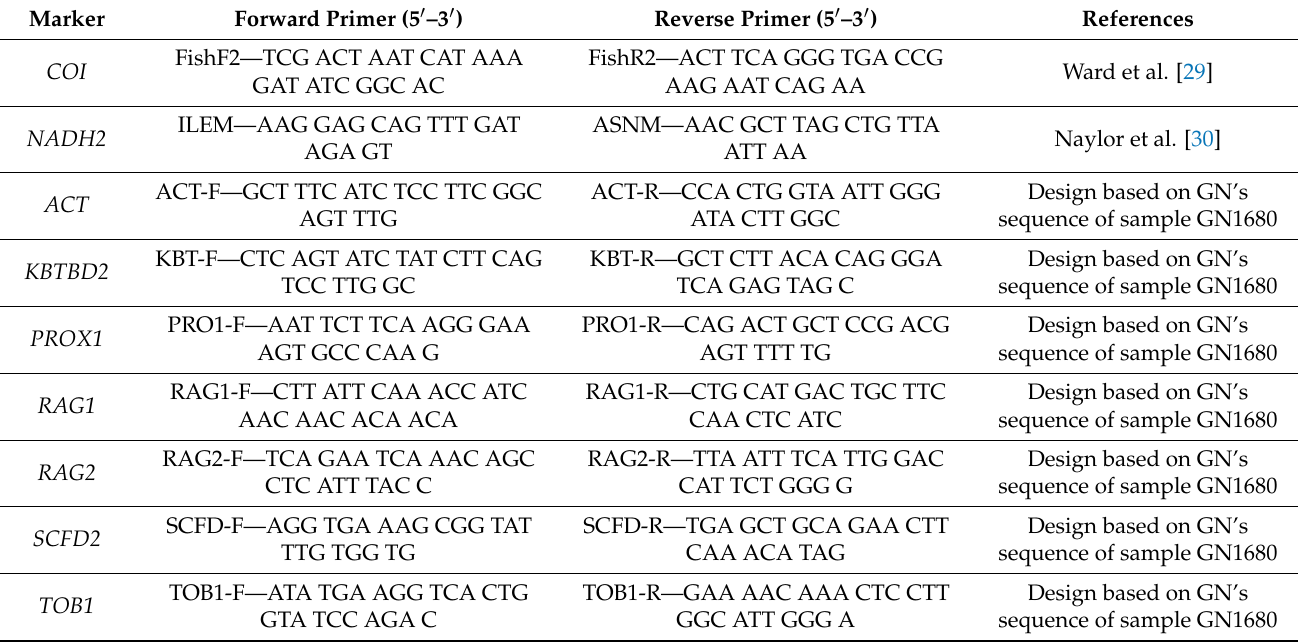
Table 1. Primers used in this study and their